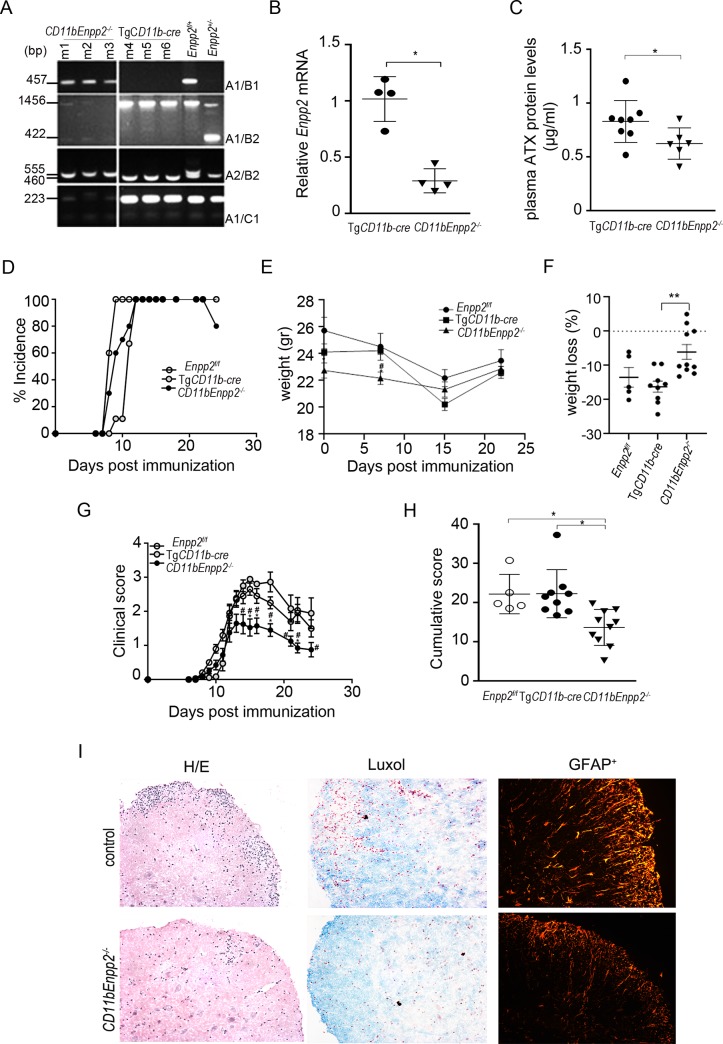
ATX genetic deletion from CD11b+ cells decreases EAE severity.(A) Genomic PCR analysis indicates appropriate recombination in the spinal cords of CD11bEnpp2-/- mice. (B) Q-RT-PCR analysis of Enpp2 mRNA levels in the spinal cords of CD11bEnpp2-/- mice and control littermates. (C) Plasma ATX protein levels. (D) EAE incidence. (E) animal weights, and (F) percentage of weight loss at the peak of the disease as compared to initial weight. (G) clinical scores, and (H) cumulative scores of EAE progression in CD11bEnpp2-/- mice and littermate controls. (I) Representative H/E (ventral funicular region) and Luxol (lateral funicular region) fast blue stained lumbar spinal cord sections and immunofluorescent staining for astrocytes (GFAP+ cells, representative images taken from the ventral and lateral area of the sections). Values, from two independent experiments, are presented as mean (± SD). Statistical significance between experimental groups was assessed with student t-test (B,C), one-way ANOVA complemented with Bonferroni multiple pair test (F,H), and Mann-Whitney Rank Sum Test (G); *denotes statistical significance (p<0.05).